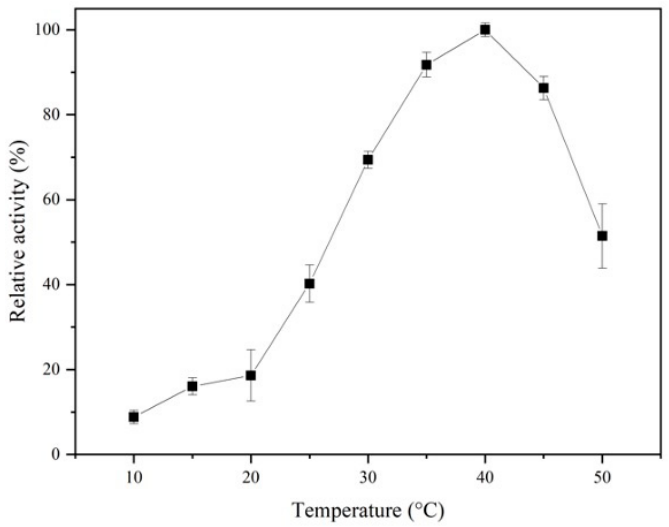
Figure 4. Effect of the temperature on ALDC activity at pH 6.0 (50 mM MES buffer). Results corre-